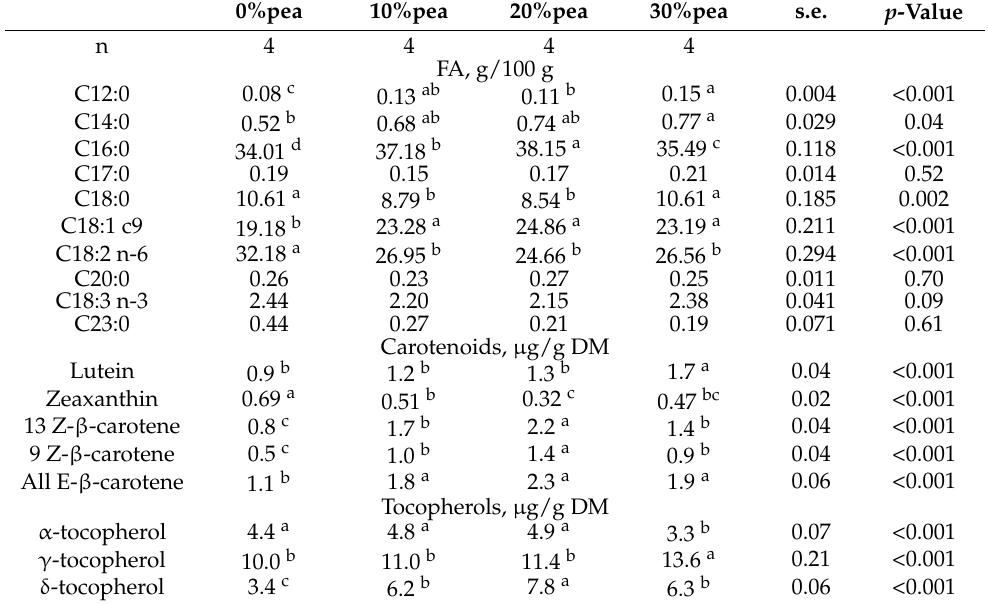
Table 1. Fatty acid (FA) profile, carotenoids and tocopherols of the concentrates with different proportions of